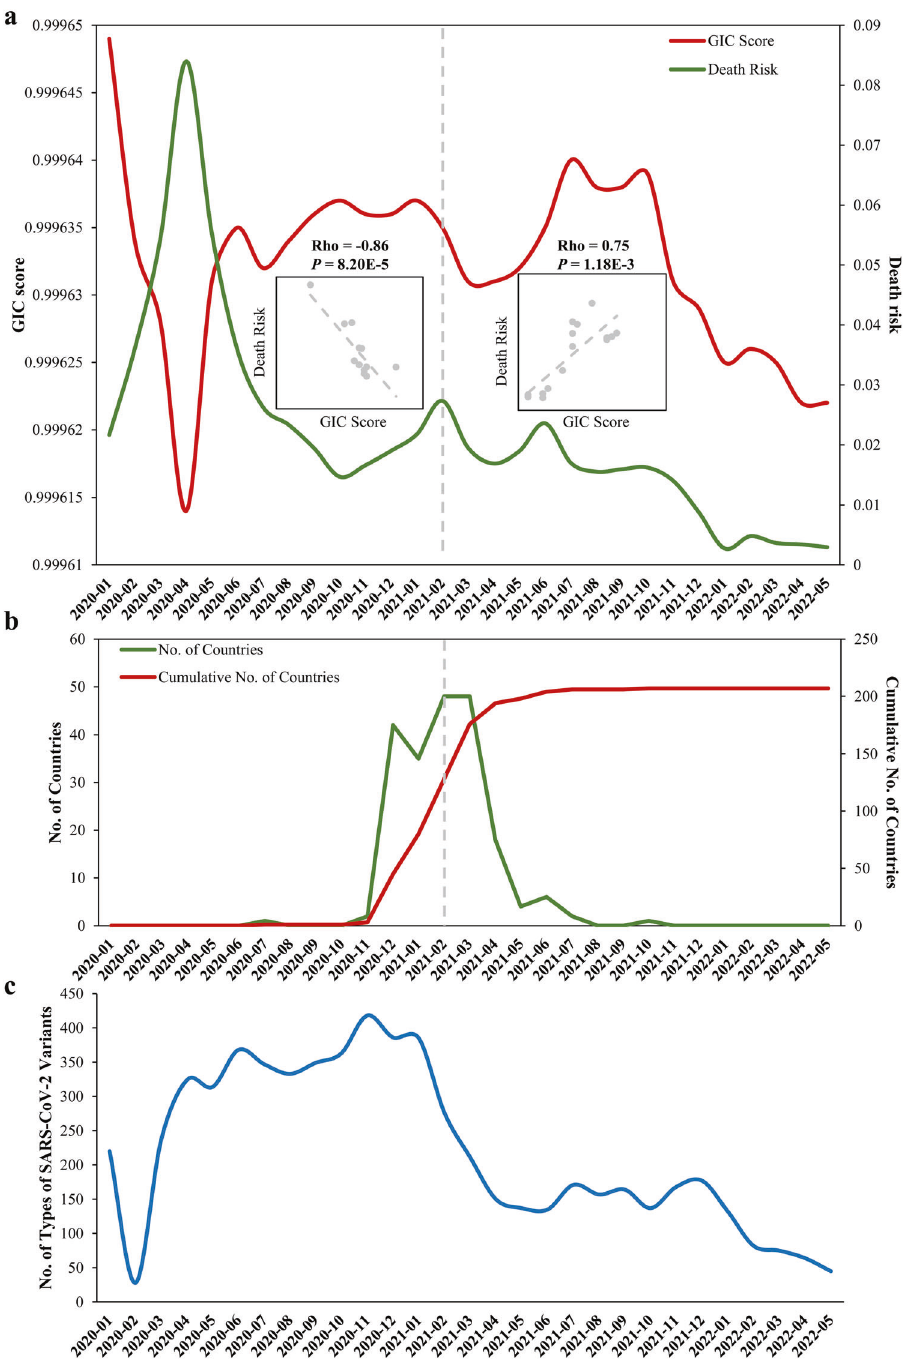
Fig. 1 Monthly changes of the importance (GIC) score of SARS-CoV-2, the death risk of COVID-19 caused by the virus, and the number of countries beginning with the fi rst vaccine. a shows that relation between the GIC score and the death risk. Their relation is negatively and positively correlated before and after February 2021, respectively. b shows the number and cumulative number of countries beginning with the fi rst vaccine. c shows the number of types of SARS-CoV-2